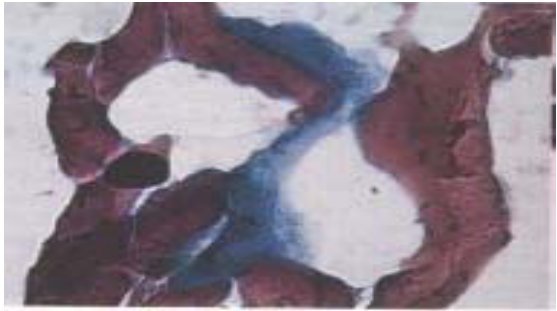
Fig. 6. Striated muscle tissue of the control samples of the refrigerated pork neck on the bone packed using MAP after 30 days of storage.